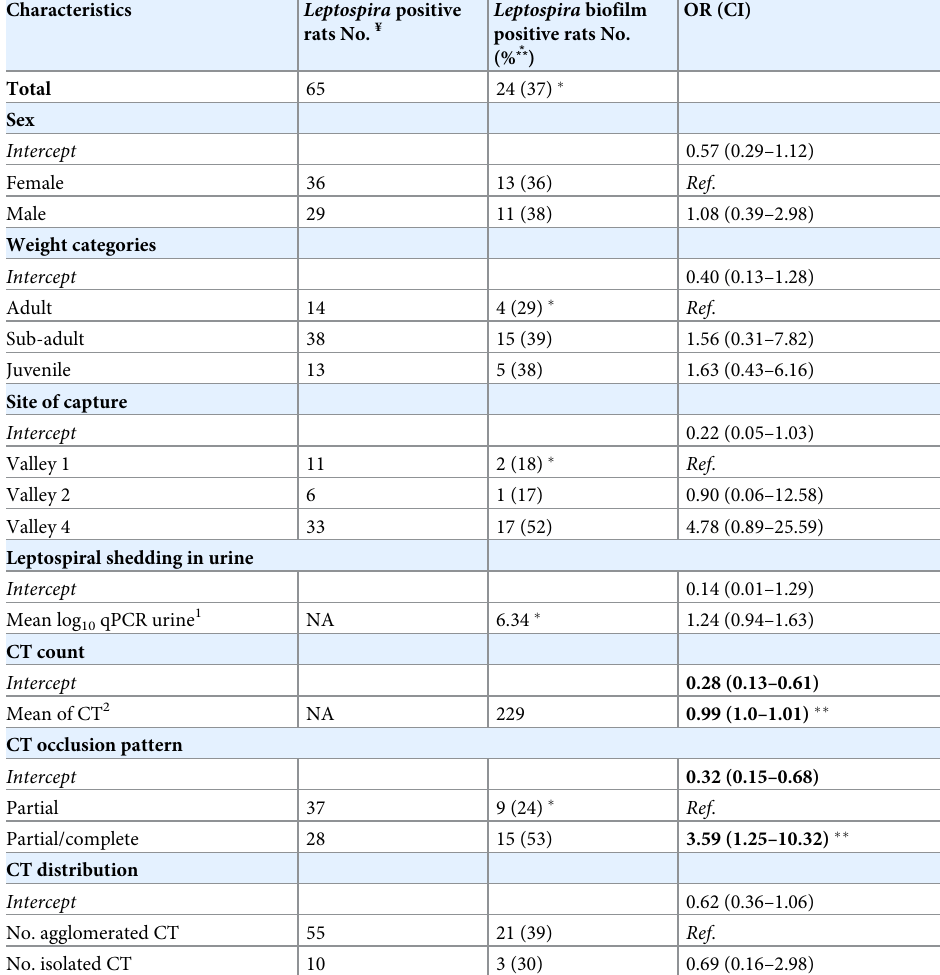
Table 1. Demographic characteristics, patterns of renal colonization and Leptospira shedding in wild Rattus nor- vegicus (Norway rats) positive for Leptospira infection and renal biofilm.